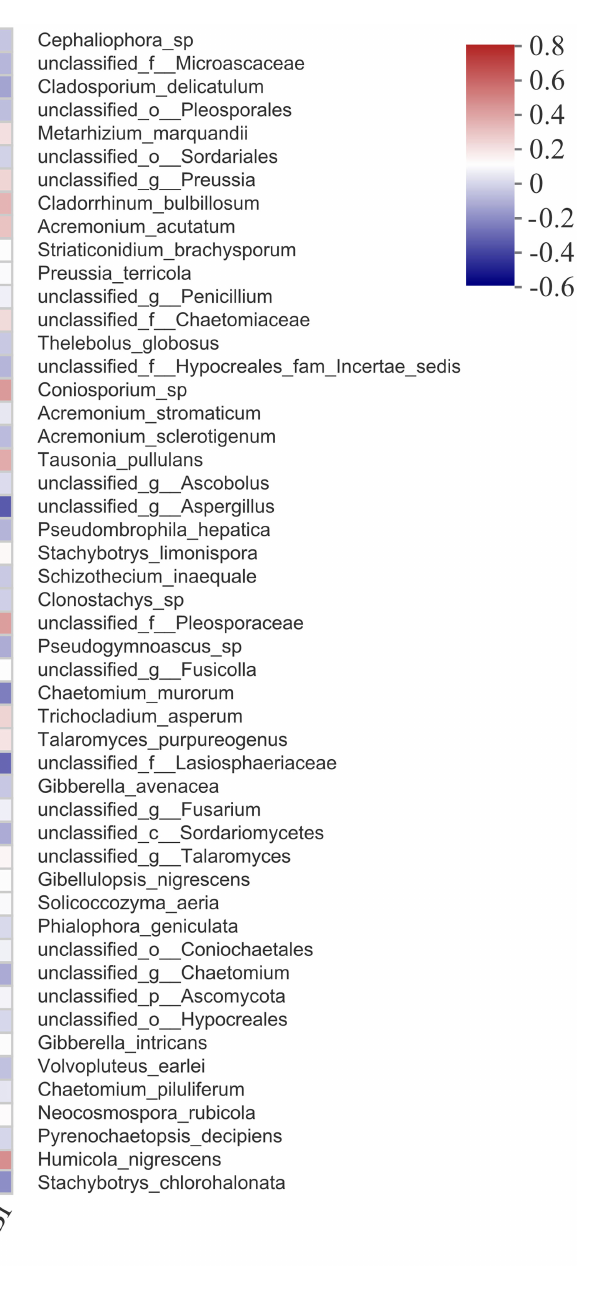
FIGURE8 Correlation analysis results showing fungal species associated with soil physicochemical properties and plant growth parameters. U, soil urease; ACP, soil acid phosphatase; P, soil available phosphorus; SOC, soil organic carbon; NO3, soil nitrate; NH4, soil ammonia; HEI, plant height; STB, stem branching numbers; RLE, root length; RSA, root surface area; RDA, root diameter; SBI, shoot biomass; RBI, root biomass; TBI, total biomass. Significance level is shown at: * p < 0.05; ** p < 0.01; *** p <